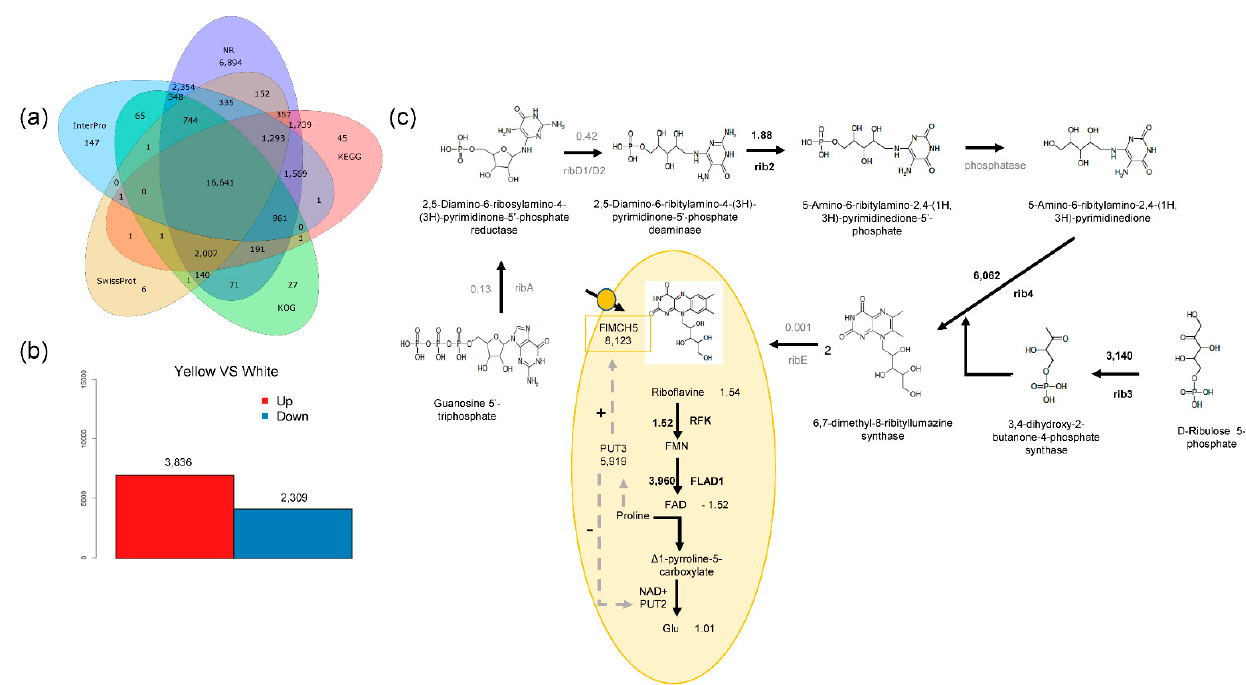
Figure 2. Comparative analysis of transcriptome between yellow and white mushrooms. ( a ) BLAST software was utilized to compare the Unigene sequence with NR, Swiss-Prot, GO, COG, KOG, and KEGG databases. ( b ) Differentially expressed genes between yellow and white mushrooms, where red represents the number of genes upregulated in white mushroom. ( c ) Simulation diagram of riboflavin metabolic pathway and riboflavin transport in cells. Arrows represent the direction of the composite, “+” represents that PUT3 positively regulates FlMCH5, and “–” represents that PUT3 negatively regulates PUT2.